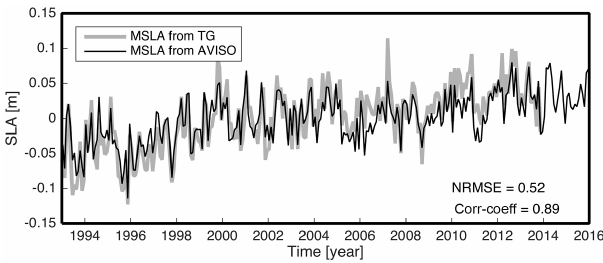
Figure 5. Spatial mean time series of sea level anomalies of tide gauge and AVISO around the Korean Peninsula without annual sig-